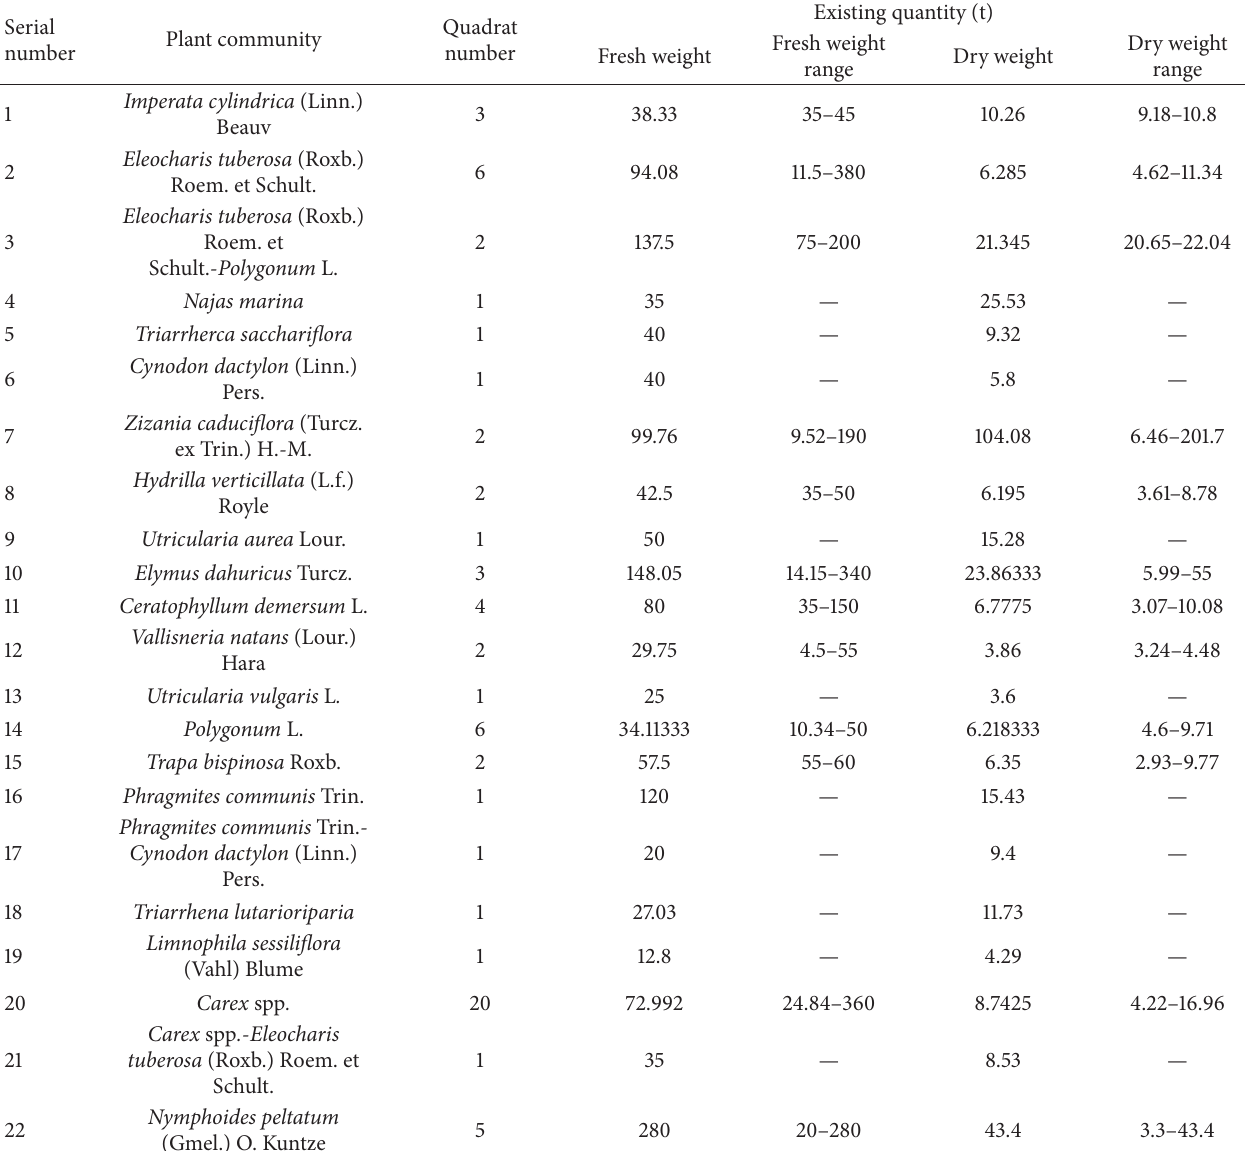
Table 4: Number of the association area and standing crop (fresh weight) in the total vegetation area and standing crop in the Poyang Lake.